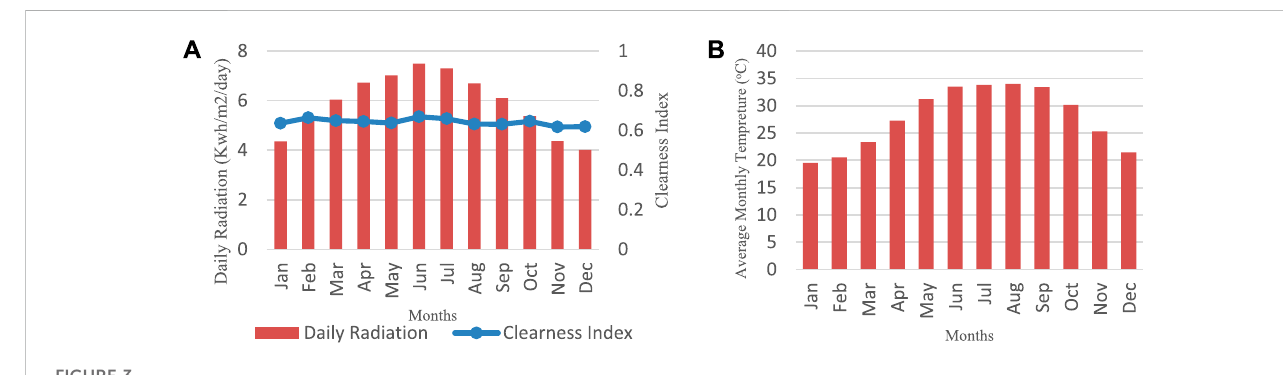
FIGURE 3 (A) Annual daily radiation and clearness index; (B) annual average temperature (The Ministry of Energy,